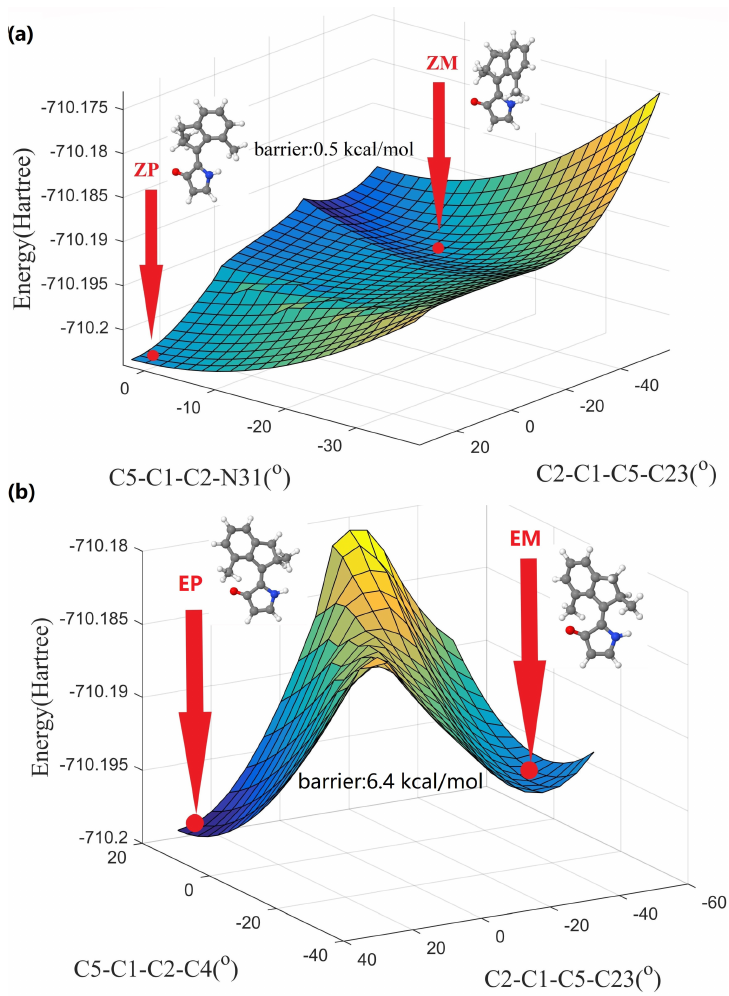
Figure 2. ( a ) Ground state potential energy surface near ZP and ZM geometries corresponding to dihedral angles C5-C1-C2-N31 and C2-C1-C5-C23. ( b ) Ground state potential energy surface near EP and EM geometries corresponding to dihedral angles C5-C1-C2-C4 and C2-C1-C5-C23. The above PESs were obtained with relaxed scan method at the CAM-B3LYP/6-31G(d) level, as implemented in Gaussian 09 program [29]. The energy barrier from ZM to ZP isomer, together with energy barrier from EM to EP isomer, are shown in subfigures ( a , b ),